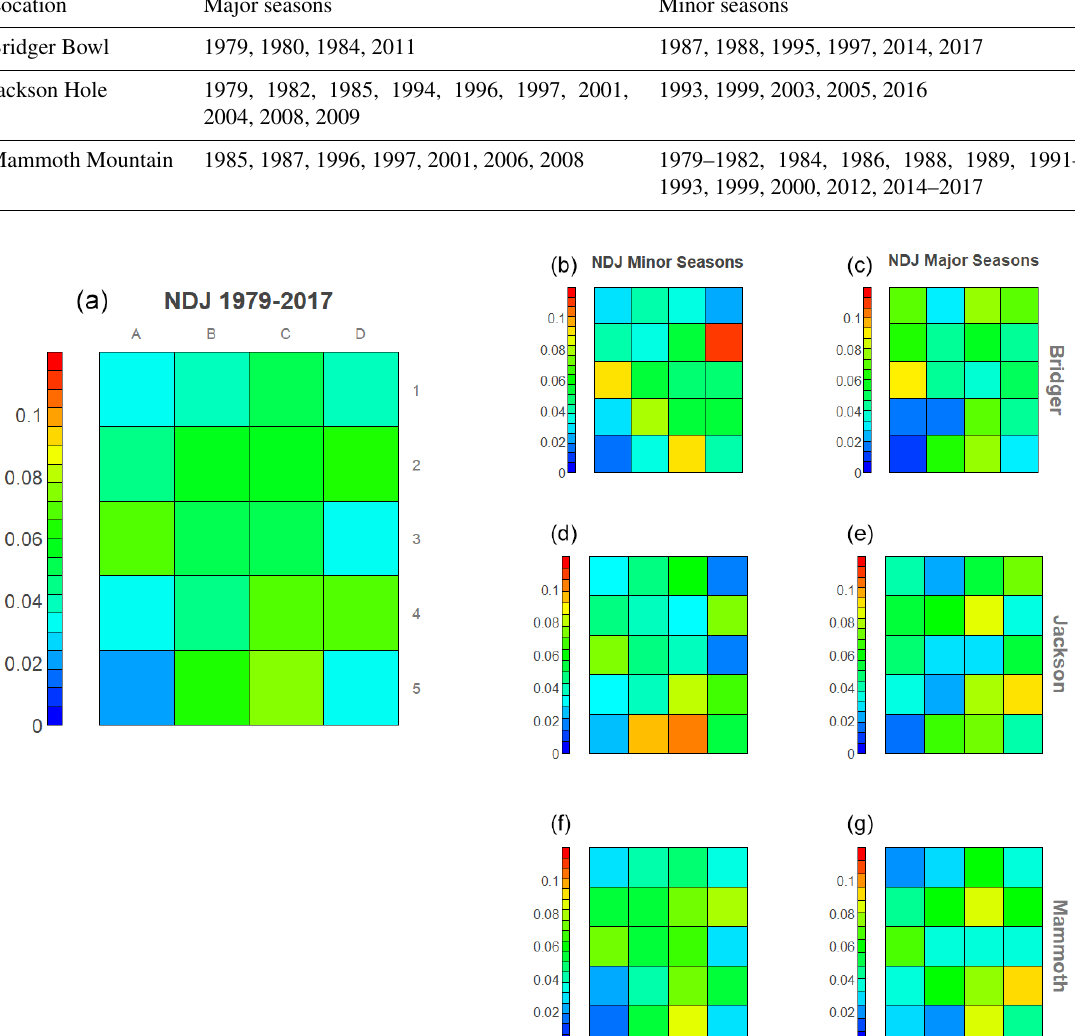
Table 4. Major and minor deep slab avalanche seasons for the three study sites, determined by cumulative seasonal DSAI score. Location